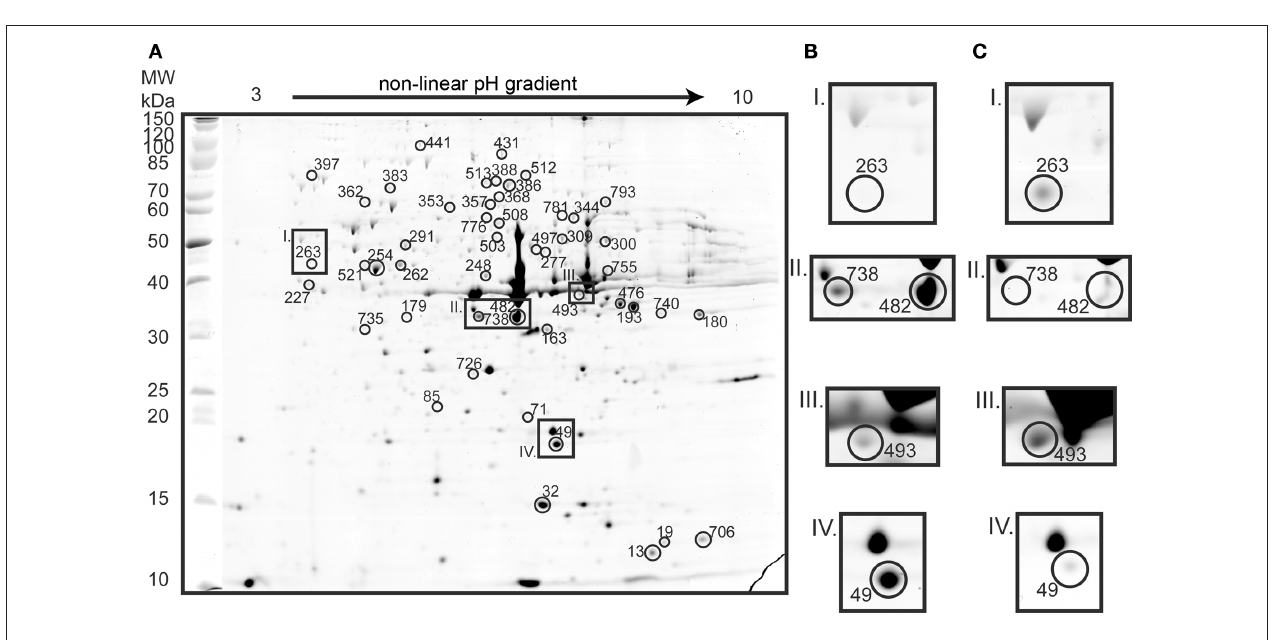
identified as hypothetical protein ACA_1144 that were unique (M738) and 10.7-fold up-regulated (M482) in gels from tetrathionate grown cells (II); type 1 secretion outer membrane protein (M493) that was 2.4-fold up-regulated in S 0 grown cells (III); and a putative lipoprotein (M49) which was 10.3-fold up-regulated on tetrathionate